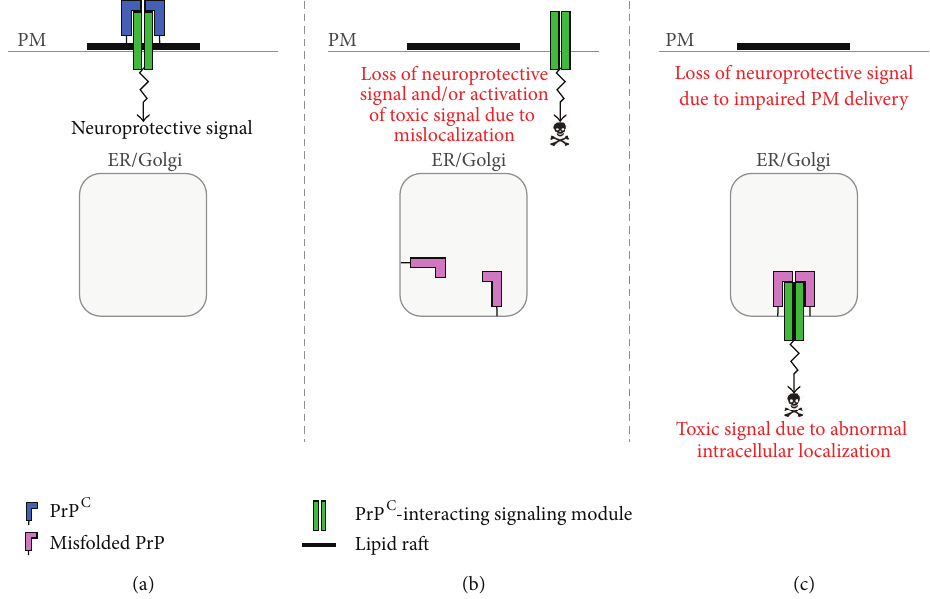
Figure 5: Theoretical model for how intracellular retention could perturb PrP C -dependent signaling. (a) PrP C acts as scaffold molecules that keep a prosurvival signaling complex in lipid rafts of the plasma membrane (PM). The lipid raft localization would be essential to activate neuroprotective signaling. (b) Owing to retention in transport organelles (ER/Golgi), PrP C function is lost and the signaling complex localizes in nonraft regions of the PM, losing its neuroprotective activity and potentially eliciting a neurotoxic signal. (c) Misfolded PrP sequesters the signaling module in intracellular compartments, leading to loss of neuroprotective function on the cell membrane. Intracellular retention might also cause the complex to function abnormally and generate a toxic